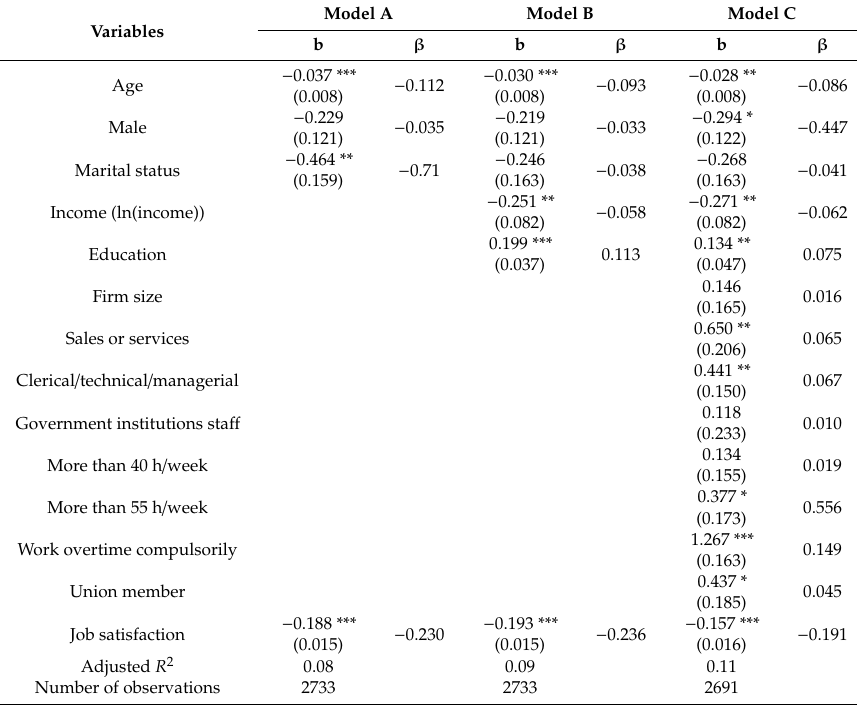
Table 4. Association between job satisfaction, objective work-related factors and